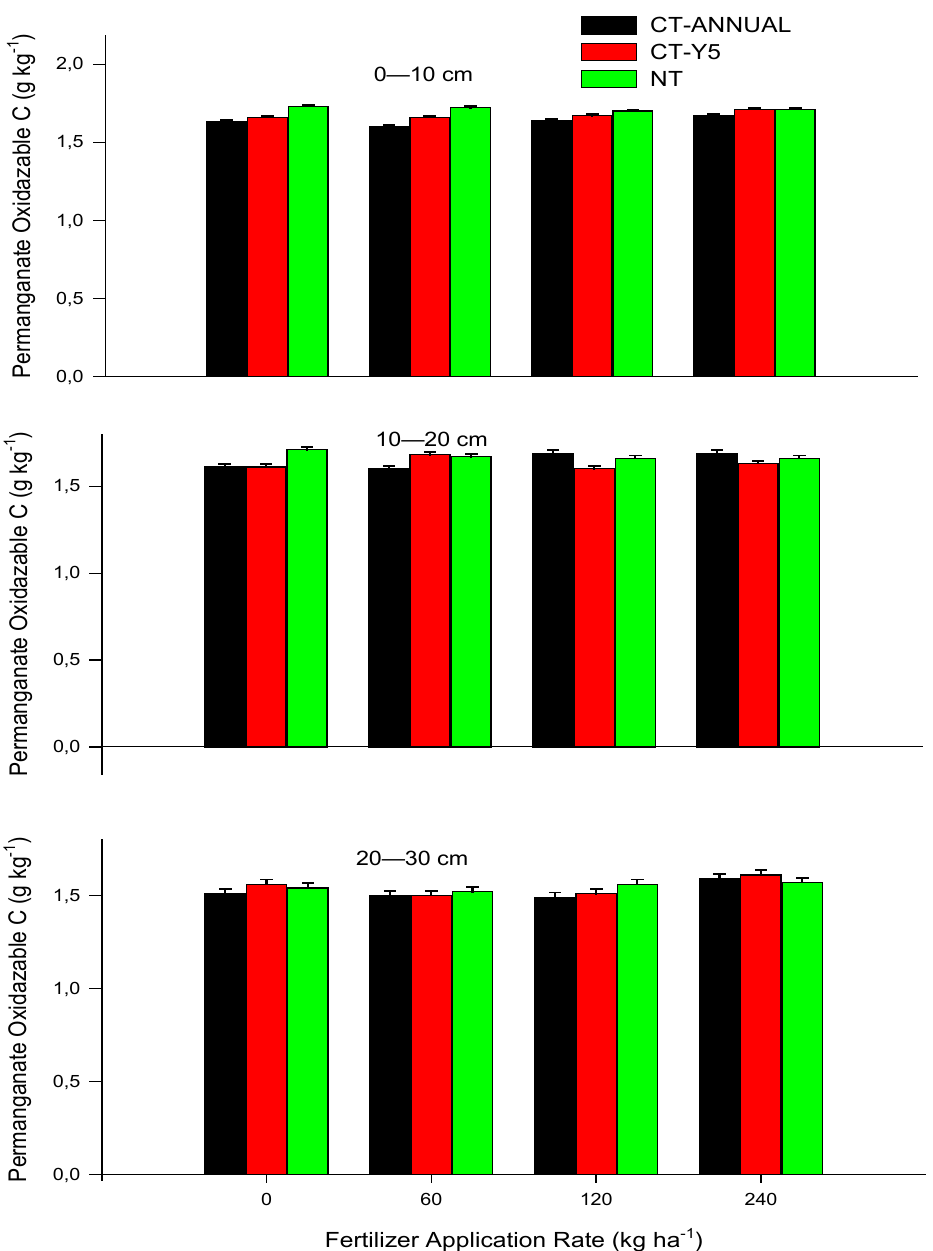
Figure 5. Permanganate oxidizable C with soil depths and urea fertilizer application (kg N/ha) for three tillage techniques.